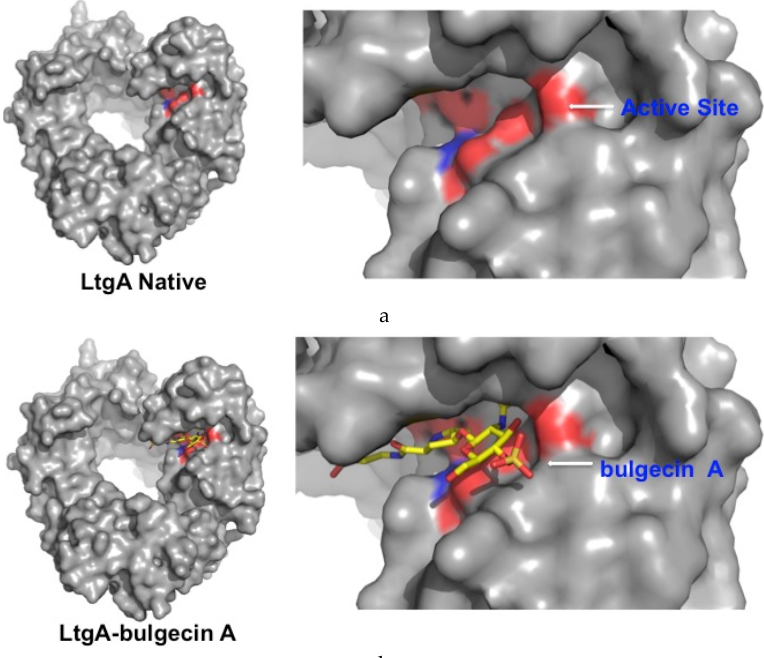
Figure 4. Surface model of LtgA native and LtgA in complex with bulgecin A. ( a ) Conserved residues that align the active site are highlighted in red; ( b ) Bulgecin A binds to the conserved active site groove.